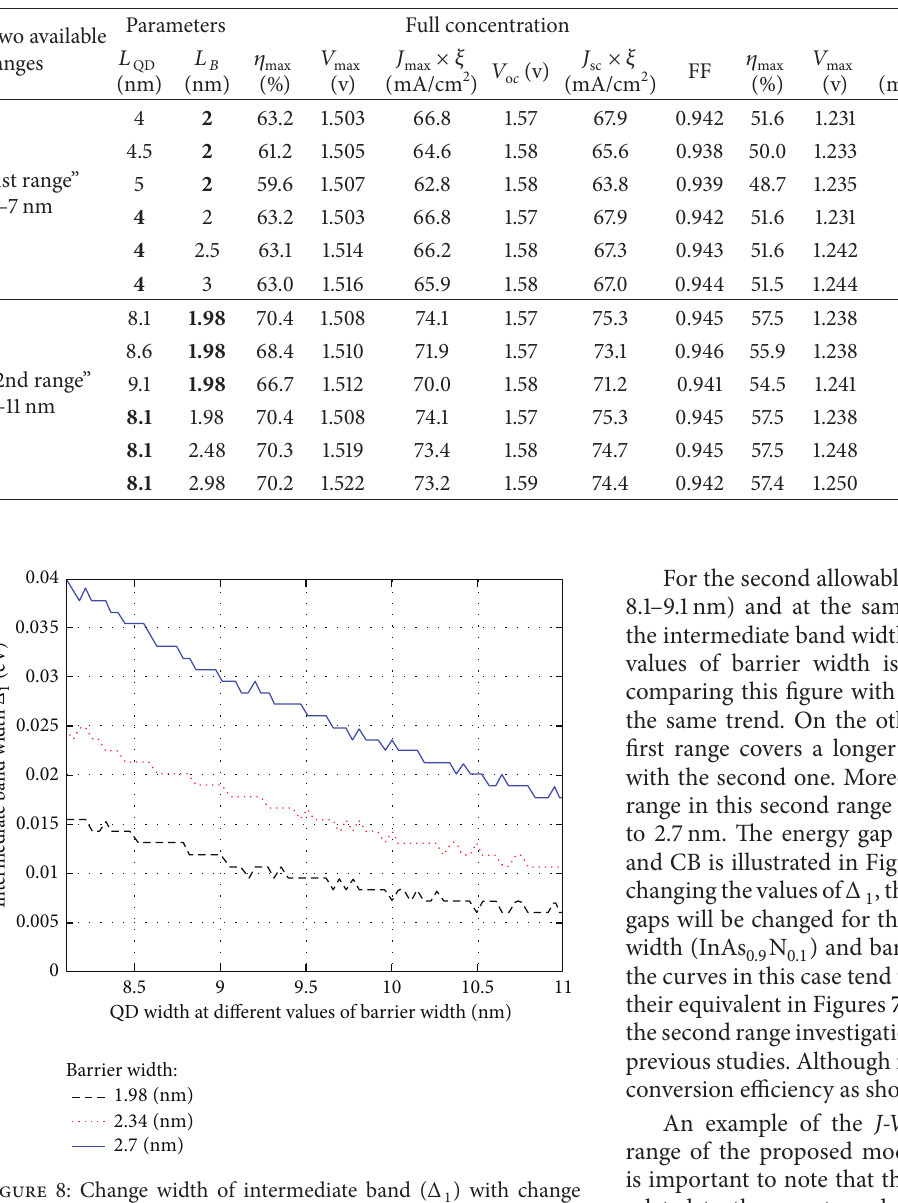
Sb ) for two different ranges of QD available widths 0.98 0.02